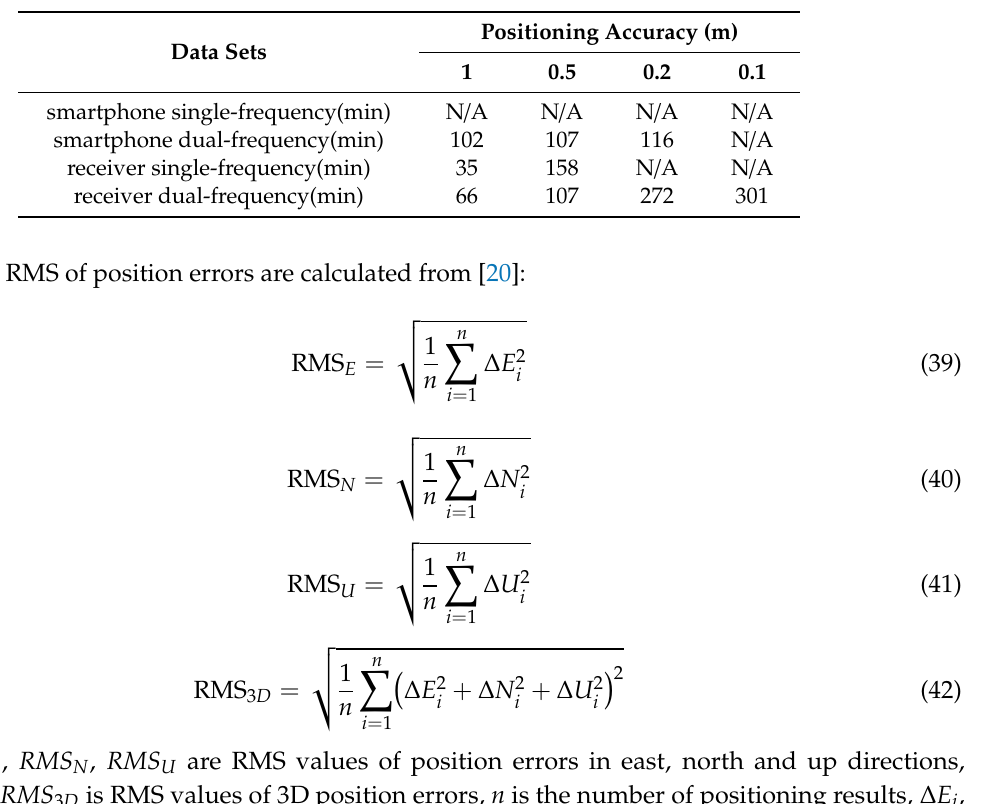
Table 3. The convergence time to di ff erent accuracies.